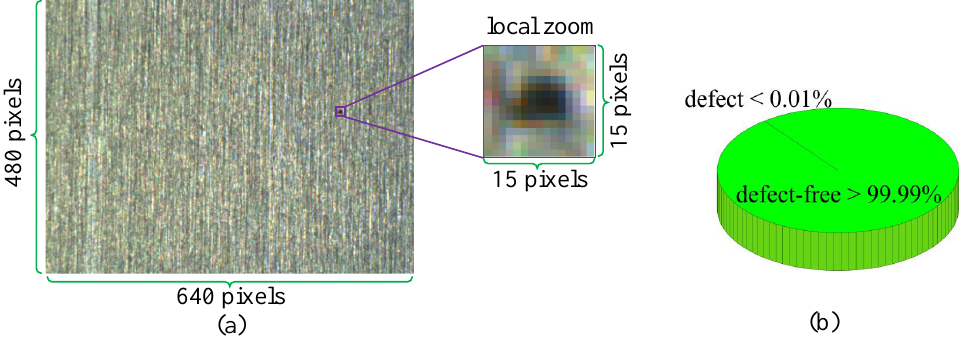
Figure 1. Examples of small surface defect dataset [54]. ( a ) Typical challenging examples of small surface defect. ( b ) The ratio is calculated over the defective or defect-free regions to an image. (1) Small defects always equate to a few pixels in size, revealing almost no other visual features, such as shape, texture, and color, which means their feature representations